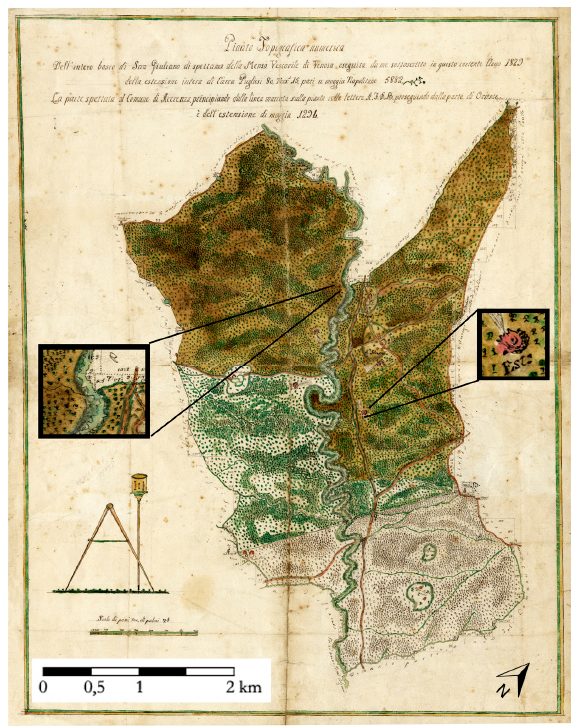
Figure 2. Historical map of the Municipality of Forenza (1829).